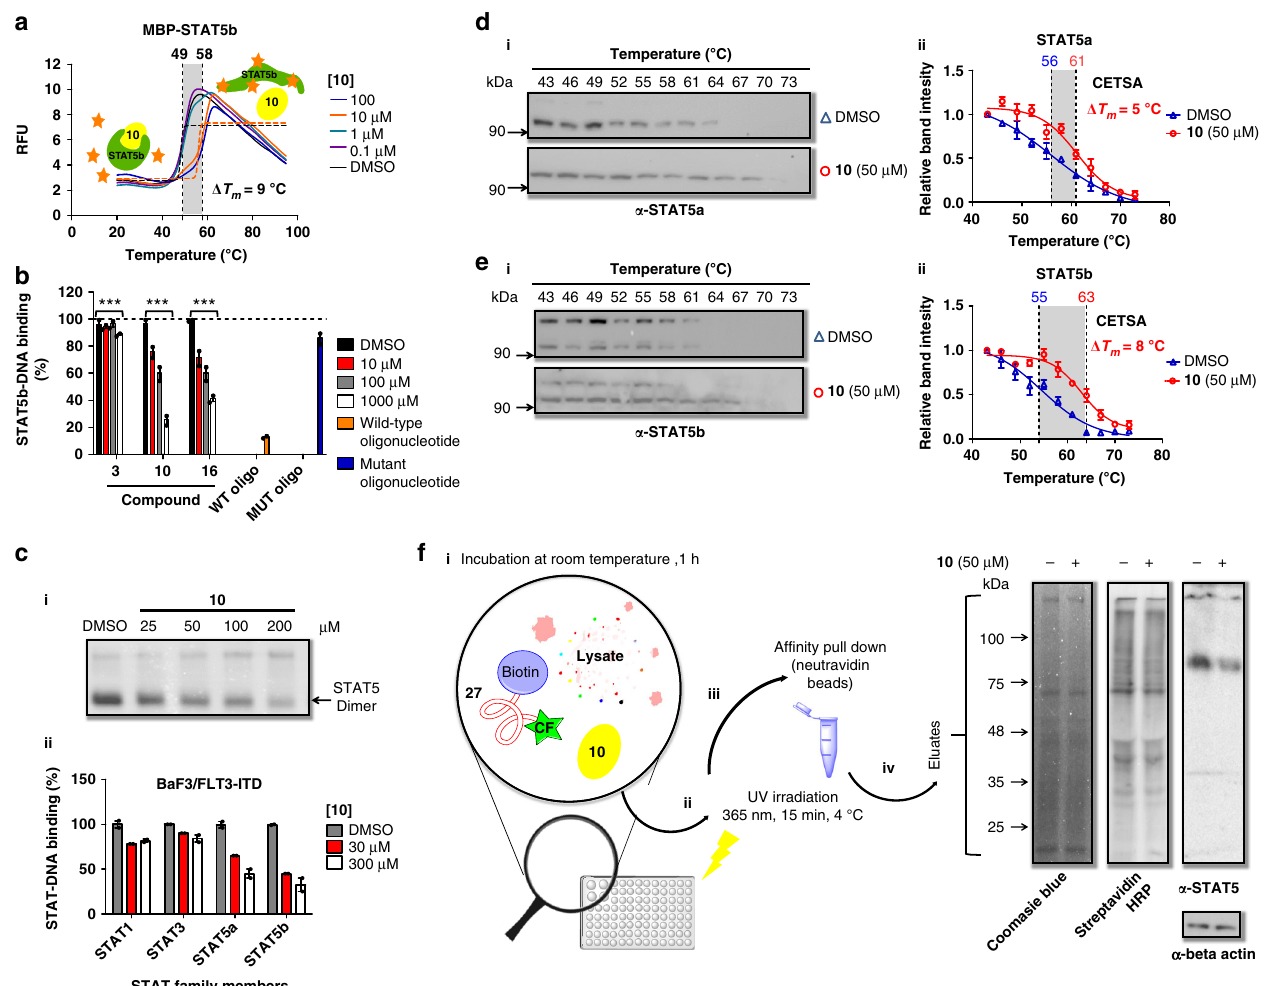
Fig. 4 Inhibitor 10 blocks STAT5 dimerization, DNA-binding, and is active in CETSA and photocrosslinking assays in cellular lysates. a 10 stabilizes MBP-STAT5b-SH2 shifting the melting temperature ( Δ T m ) by 9 °C in the TSA (data shown are one representative example of n = 3). b 10 and 16 inhibit formation of trimeric (STAT5b) 2 -DNA complexes in an ELISA ( n = 3). c ( i ) 10 inhibits binding of STAT5 dimers, isolated from nuclear extracts of BaF3/ FLT3-ITD cells, to its target DNA in the electro mobility shift assay (EMSA) and ( ii ) shows selectivity for disrupting STAT5a,b-DNA complexes in the TransAM ® STAT family ELISA ( n = 3). d – e 10 binds to STAT5a and STAT5b in complex cellular lysates as demonstrated by cellular TSA (CETSA), resulting in shifted melting curves at 50 µ M compared with vehicle (DMSO). Relative STAT5a and STAT5b band intensities were plotted against corresponding incubation temperatures and fi tted to Boltzmann sigmoidal curve. The blue triangle represents DMSO and red circle represents compound 10 ( n = 3). f Binding of 10 to STAT5 in BaF3/FLT3-ITD cell lysate was determined by photo-crosslinking ( n = 3). ( i ) The dual-labeled (carboxy fl uorescein and biotin) peptide probe 27 binds to STAT5 with submicromolar af fi nity and photocrosslinked ( ii ) with target proteins by activating the 4-phosphoncarbonyl residue that acts as a photoactive phosphotyrosine-mimetic. ( iii ) Cross-linked proteins can be isolated by biotin pull-down using Neutravidine beads. ( iv ) Displacement of 27 (100 µ M ) by compound 10 (50 µ M ) in BaF3/FLT3-ITD cell lysates (1 mg ml − 1 ) resulted in signi fi cantly reduced photo-crosslinking of 27 and STAT5 as demonstrated in the western blotting using STAT5 antibodies (right lane), whereas other biotinylated proteins were not reduced (middle lane). For an uncropped image of c , d , e , f see Supplementary Figure 10. Error bars denote mean ± S.D. and p values are considered as follows: * p value < 0.05; ** p value < 0.01; and *** p value < 0.001. Statistical analyses were performed using one-way ANOVA or the two-tailed Student ’ s t tests where appropriate